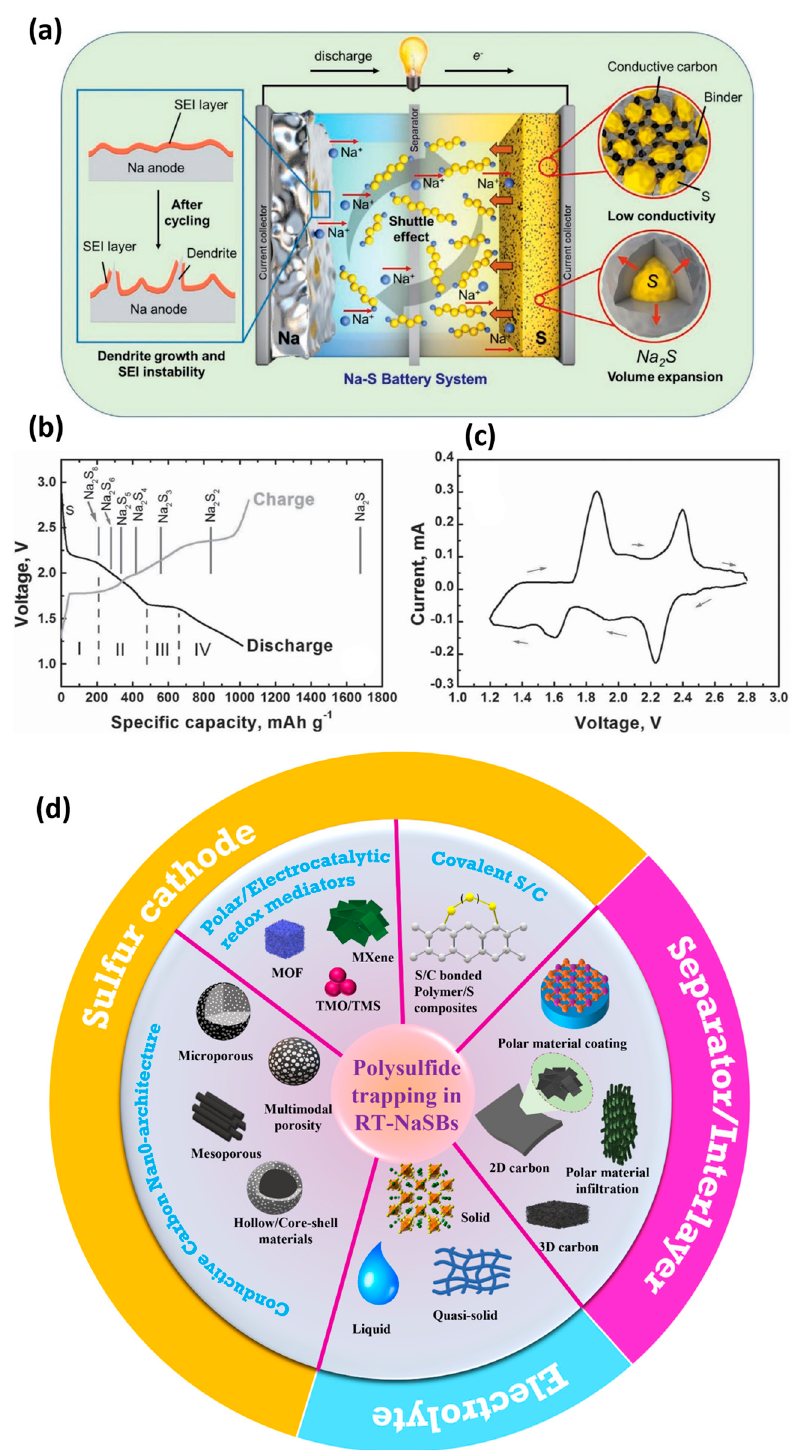
Figure 2. ( a ) Schematic illustration of RT − NaSBs. Reproduced with permission [21] Copyright 2021, Wiley. ( b ) Typical voltage and ( c ) CV pro fi le of RT − NaSBs. Reproduced with permission [24]. Copyright 2015, Wiley. ( d ) Schematic illustration of the NaPS adsorption strategies employed in RT − NaSBs.